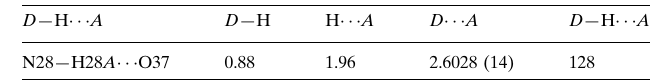
Hydrogen-bond geometry (A˚ , (cid:2)